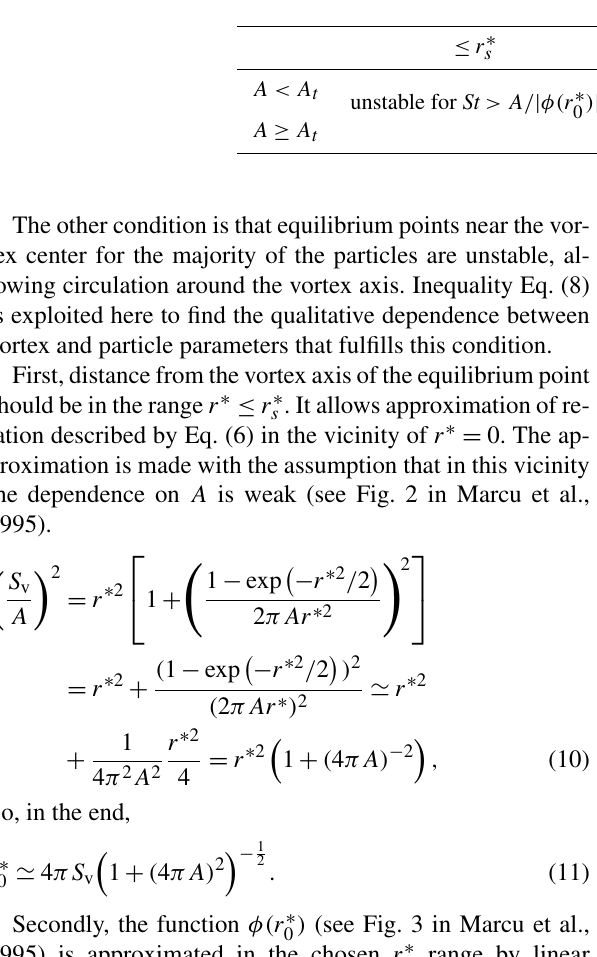
Table 4. Stability conditions of particle equilibrium points present in the Burgers vortex with respect to vortex strain parameter A and dimensionless distance from the vortex axis r ∗ . A t , ϕ(r ∗ ) , r ∗ s , r ∗